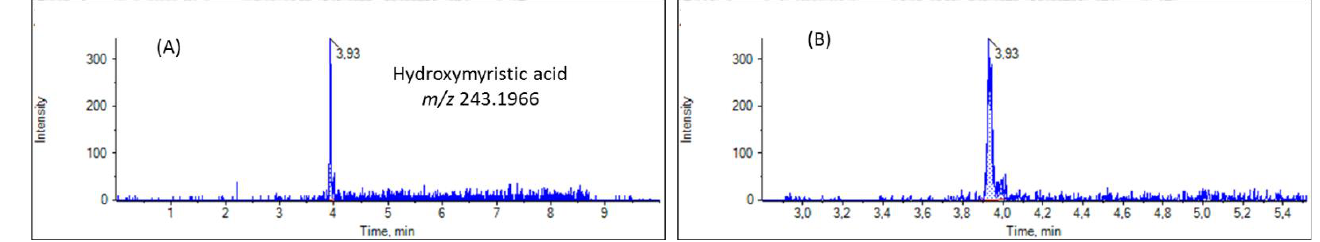
Figure 6. EICs of hydroxytetradecanoic acid ( A ) and zoom ( B ) in a representative RJ sample.